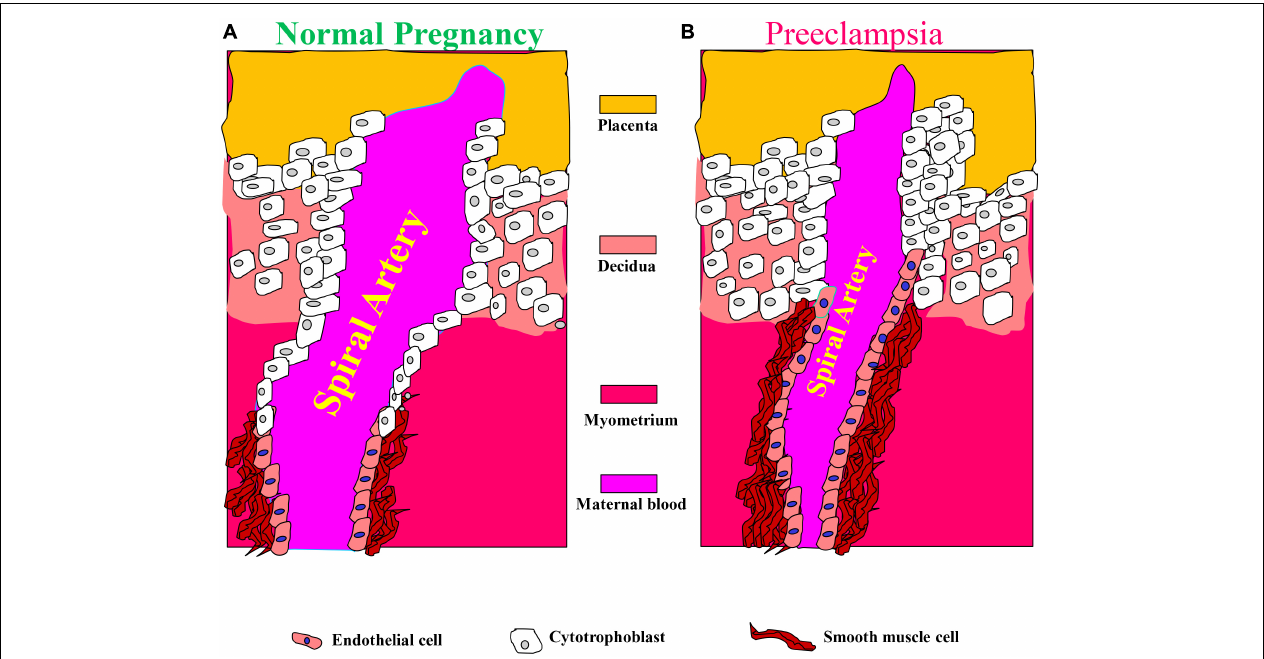
FIGURE 2 | Aberrant placentation and angiogenesis in preeclampsia. In normal pregnancy, cytotrophoblasts of fetal origin invade the maternal spiral arteries and replace endothelial cell layer. This action converts the spiral arteries from narrow highly resistant vessels to high-caliber capacitance vessels, which are capable of providing sufficient blood and nutrition supply to the fetus. During the process of vascular invasion, the cytotrophoblasts differentiate from an epithelial to an endothelial phenotype, a process referred to as pseudovasculogenesis, or vascular mimicry ( Right ). In preeclampsia, cytotrophoblasts fails to acquire invasive endothelial phenotype features, thus the invasion of the spiral arteries is inadequate leaving them narrow and highly resistant ( Left ). Modified with permission from Lam et al. (2005) and Powe et al.